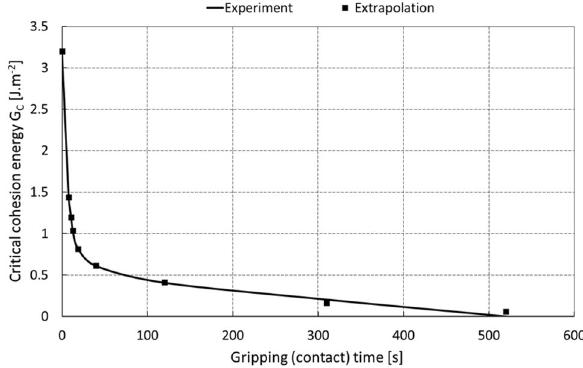
Fig. 21 Course of the contact